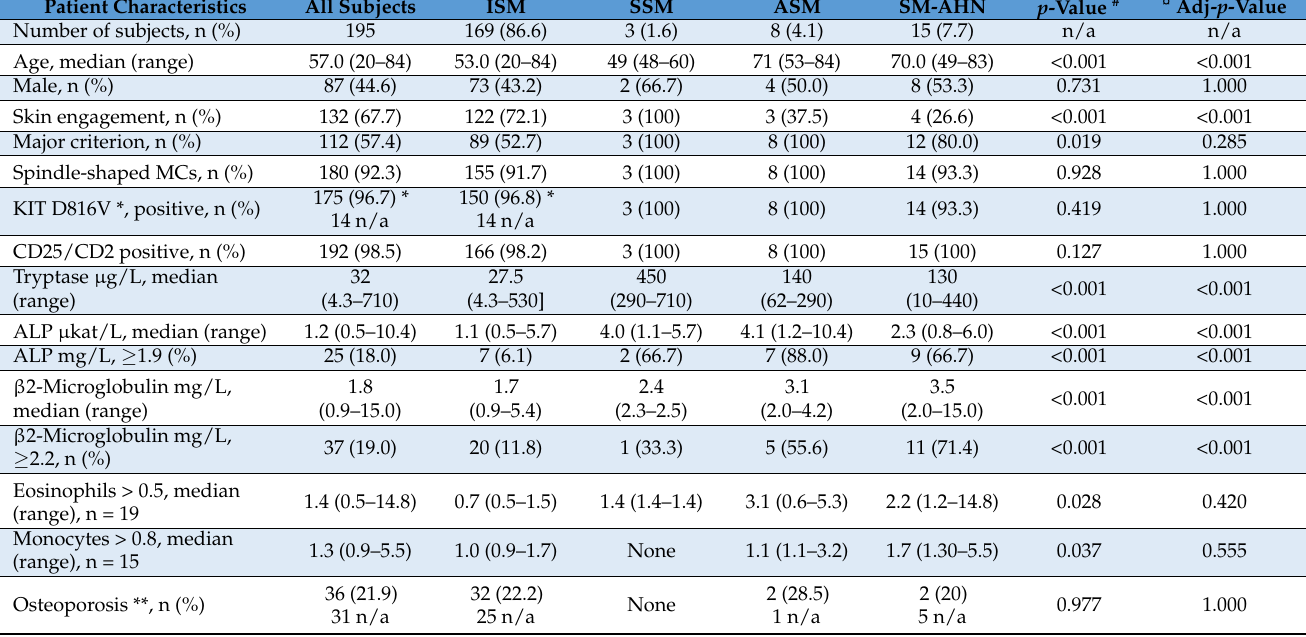
Table 1. Demographic and clinical characteristics of the enrolled subjects by variant of systemic mastocytosis at